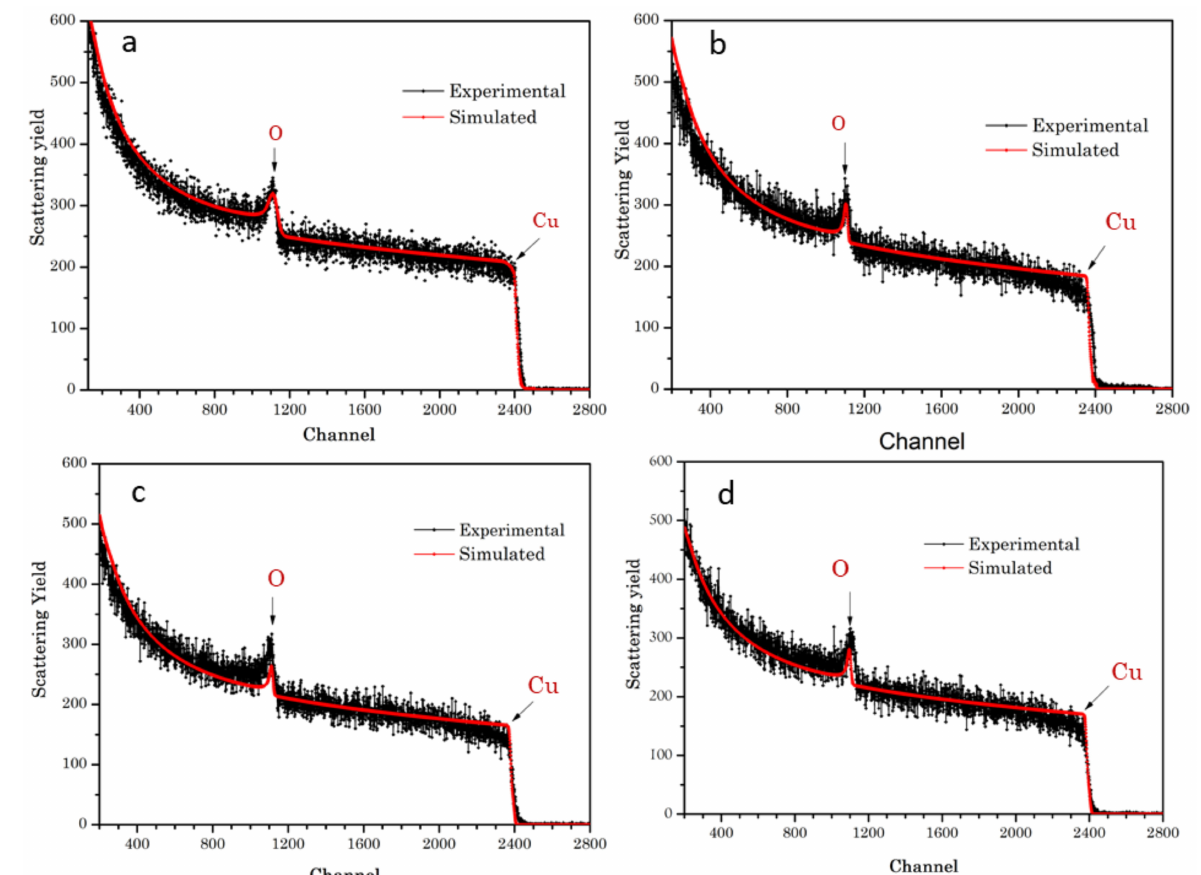
Figure 8. RBS spectra of CuO ( a ) at 700 rpm, ( b ) 800 rpm, ( c ) 900 rpm, and ( d ) 1000